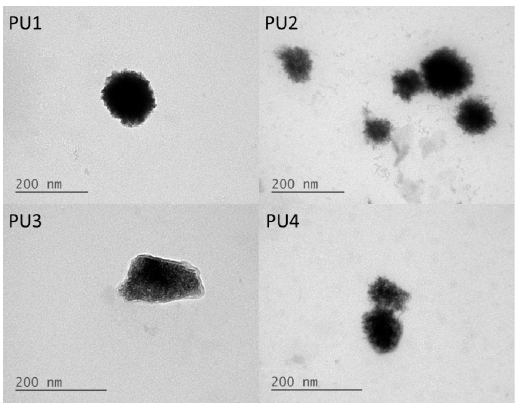
Figure 2. TEM images of PU1, PU2, PU3 and PU4 in the aqueous dispersions.